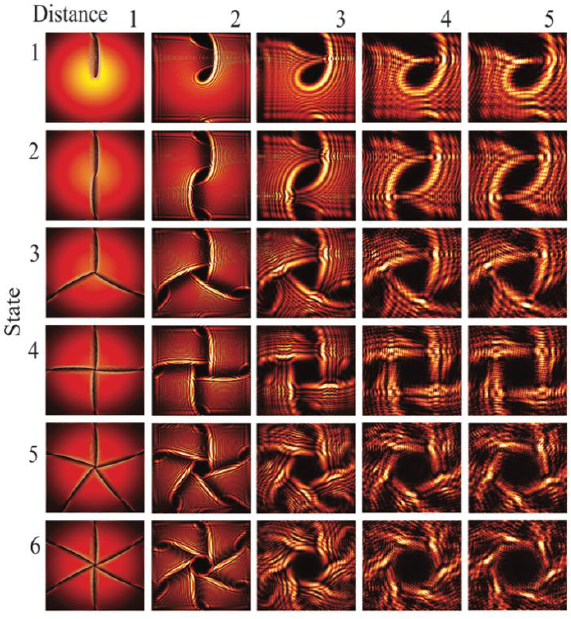
Figure 3. Simulated intensity profiles of Kind-3 beams propagated at distances 0.01, 0.3, 1, 1.6, and 2 meters, for states ℓ = 1 through 6.